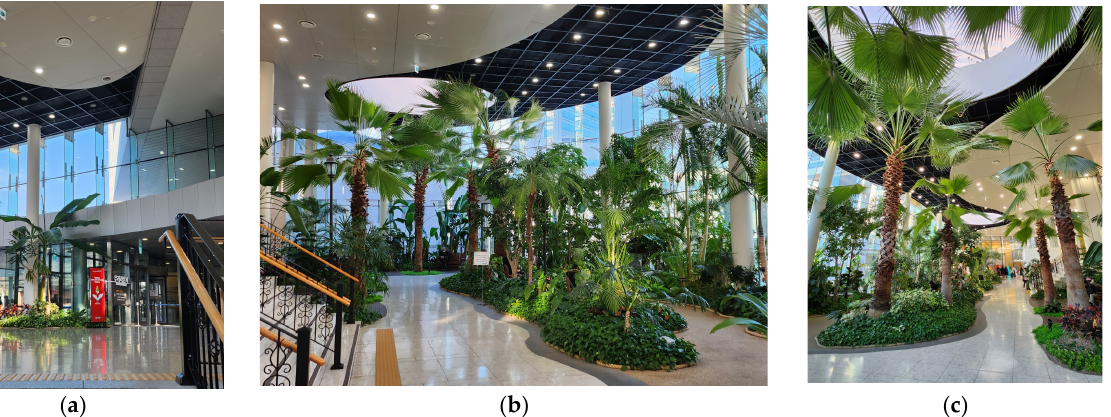
Figure 4. ( a ) The lounge is located in-between two buildings and connects them- the medical re- plants, undulating walkways, and benches; ( c ) Daylight is introduced through the glazed curtain signed by Gansam Co.,